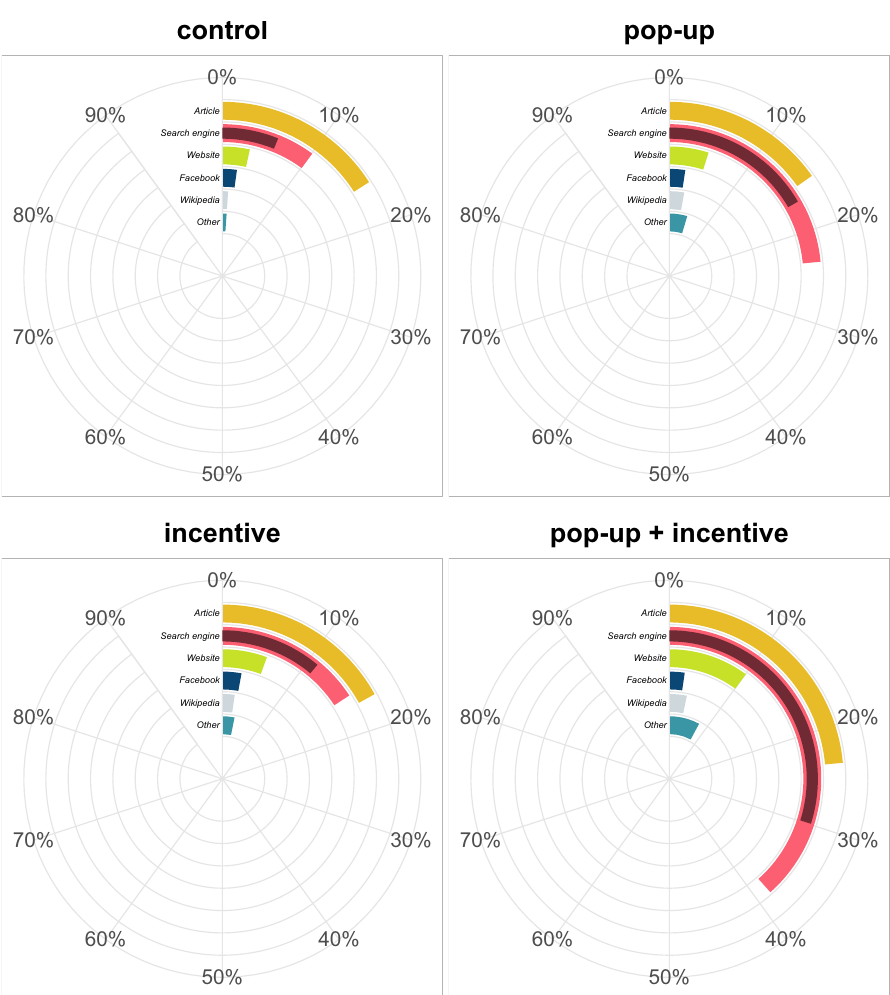
Figure 6. Race chart of self-report external search behaviour. Bars indicate the proportion of participants in each experimental condition reporting to have searched in either category of websites. Lateral reading is identified with the proportion of participants searching information on a search engine (light red), whereas click restraint is the subset of these participants who reported not stopping at the first algorithmically-ranked results of the search (dark